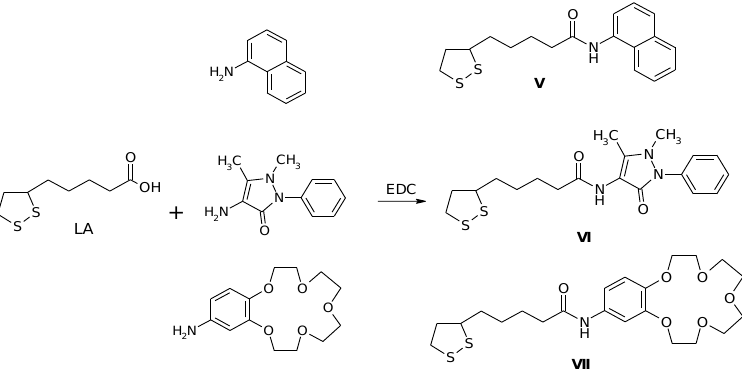
Figure 3. Synthesis of the compounds V – VII starting from LA.